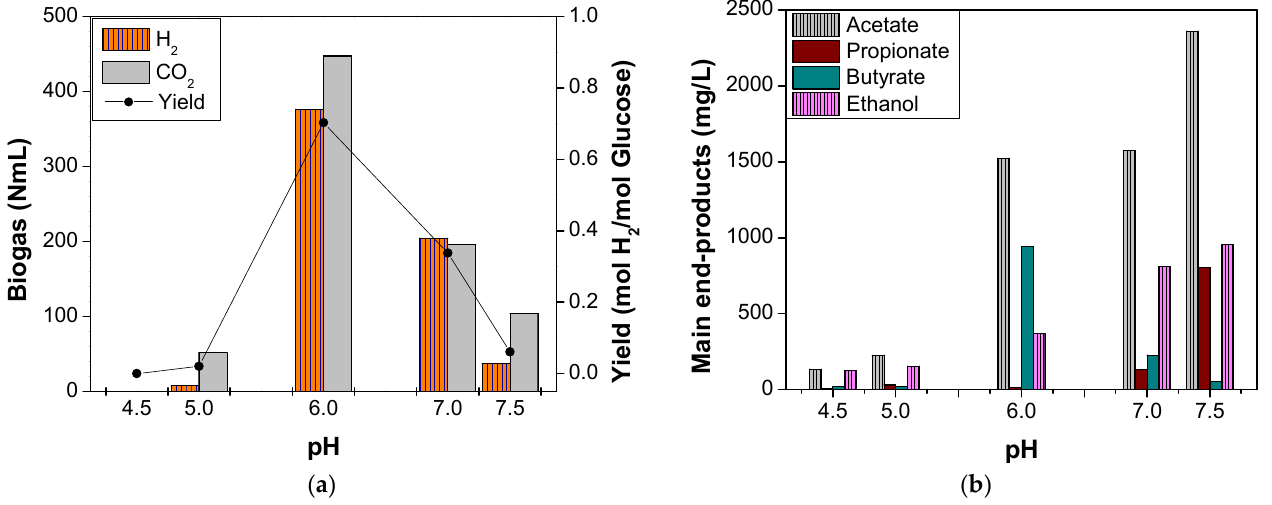
Figure 2. Effect of pH on thermophilic OMW DF. ( a ) Biogas and hydrogen yields presentation. ( b ) Main end products presentation.